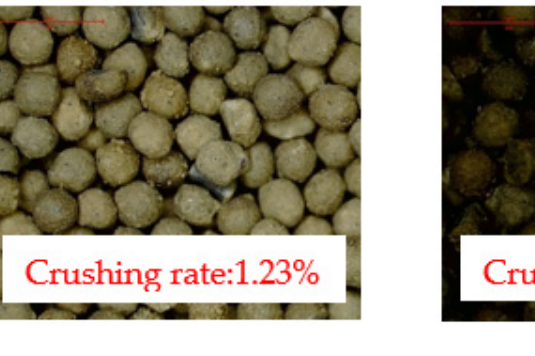
Table 2. Conductivity damage response surface factor level